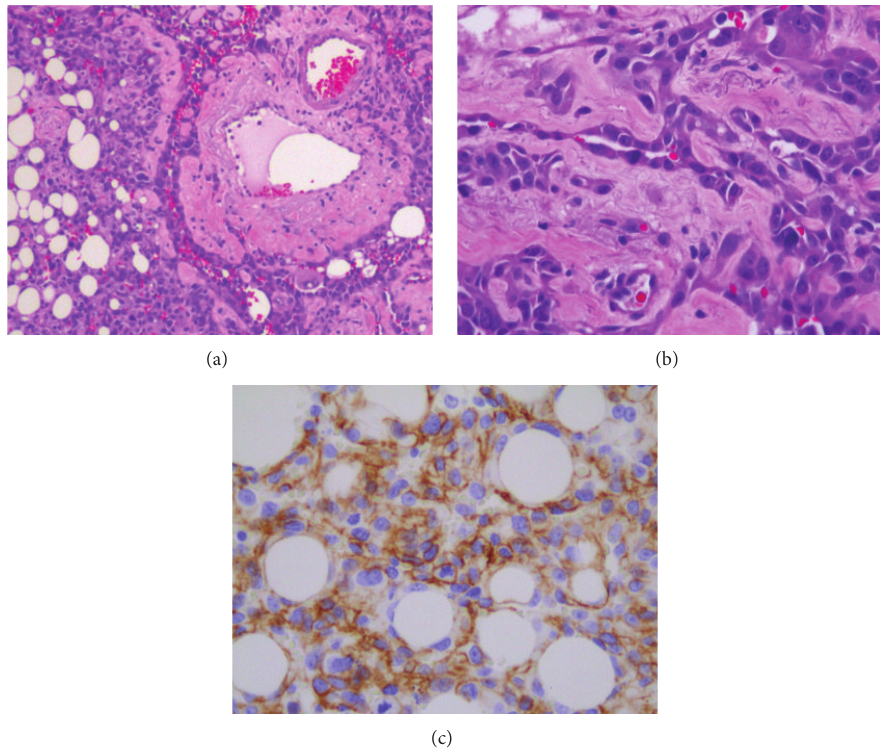
Figure 2: Pathologic analysis of omental epithelioid angiosarcoma. (a) H&E 100x: vascular proliferation replacing omental adipose tissue, (b) H&E 400x: tumor cells form complex vascular channels, and (c) CD31 400x: tumor cells expressing vascular marker